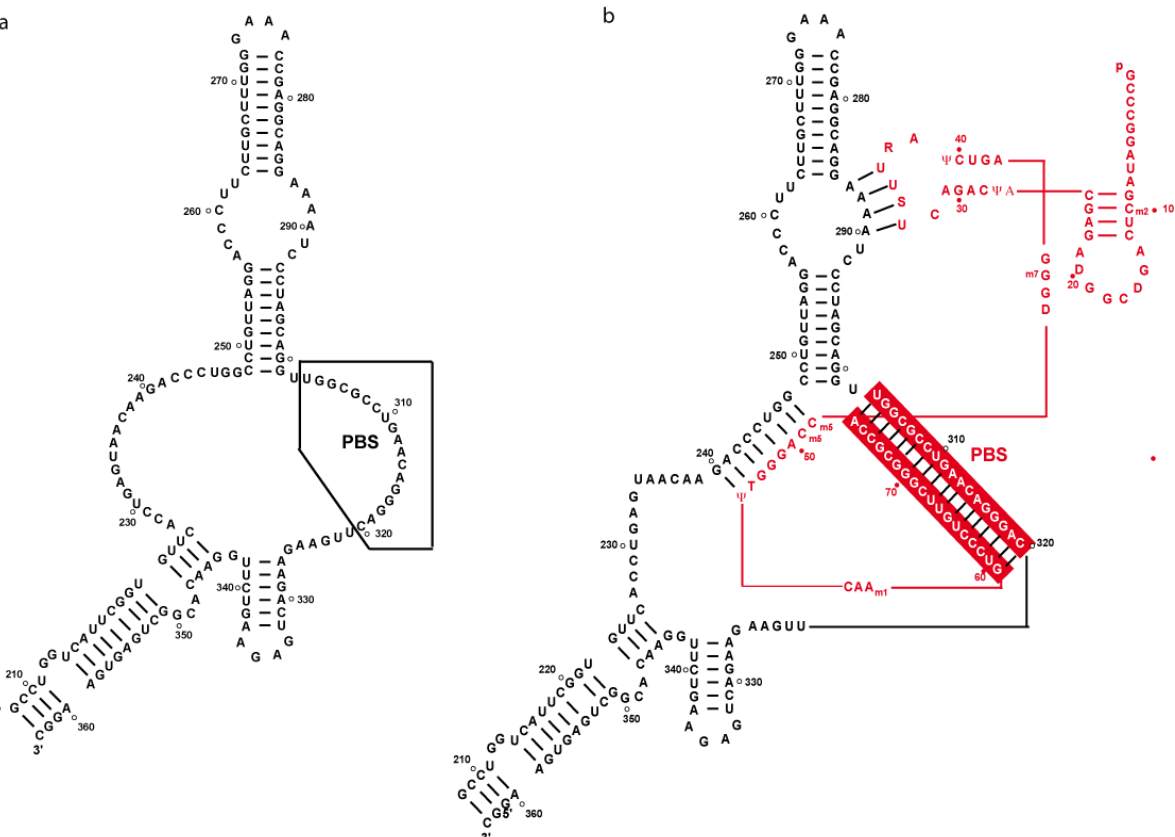
Figure 5. Secondary structure models of the HIV-2 vRNA ( a ) and of the vRNA/tRNA 3Lys complex ( b ). The tRNA is in red and the vRNA in